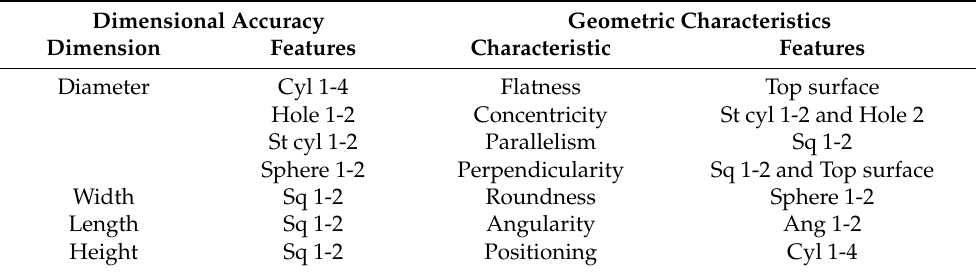
Table 8. Types of Features used for dimensional accuracy and geometric characteristics measurements. Dimensional Accuracy Geometric Characteristics Dimension Features